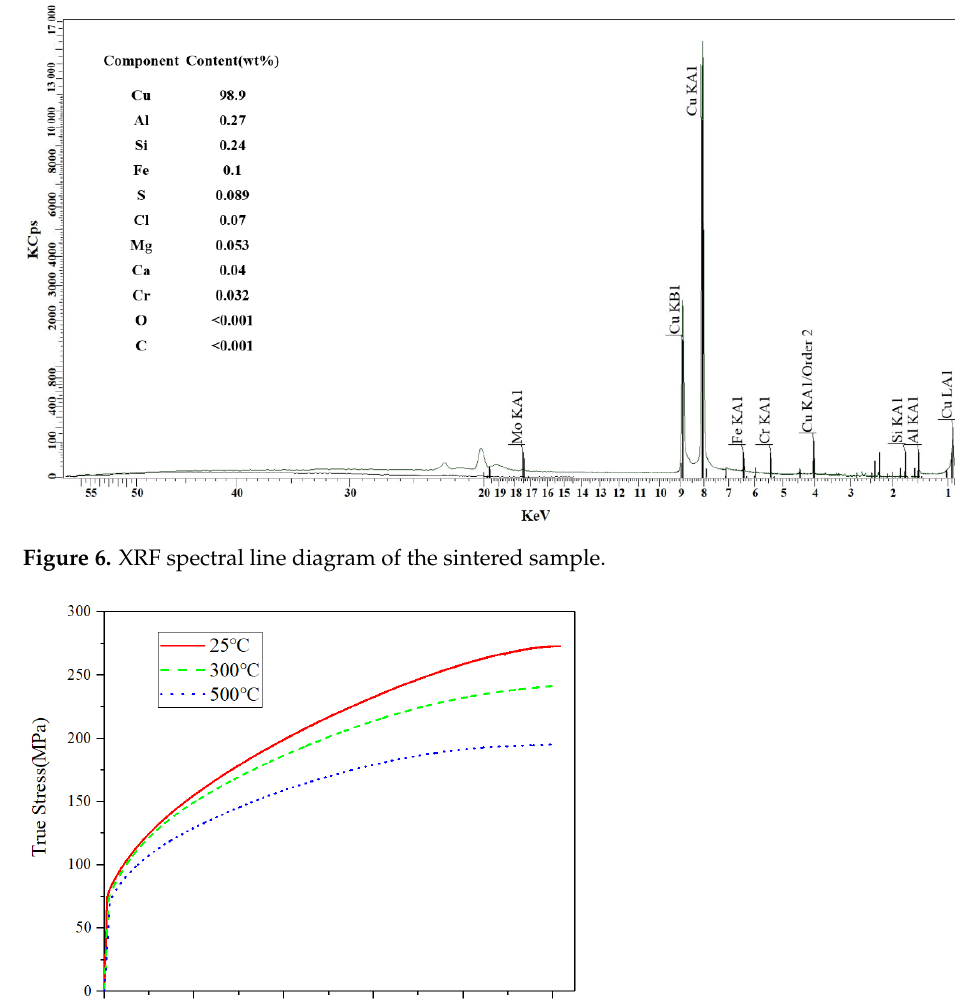
( d ) Figure 5. Scanning electron microscope micrograph of the metal matrix, of which the slice was cut from the copper foam ( a ) before and ( b ) after sintering; metallographic photos ( c ) before and ( d ) after corrosion of metal matrix. Figure 6 shows the XRF spectral line diagram of the sintered sample, in which the main elements and their contents can be obtained. It can be clearly seen that the intensity